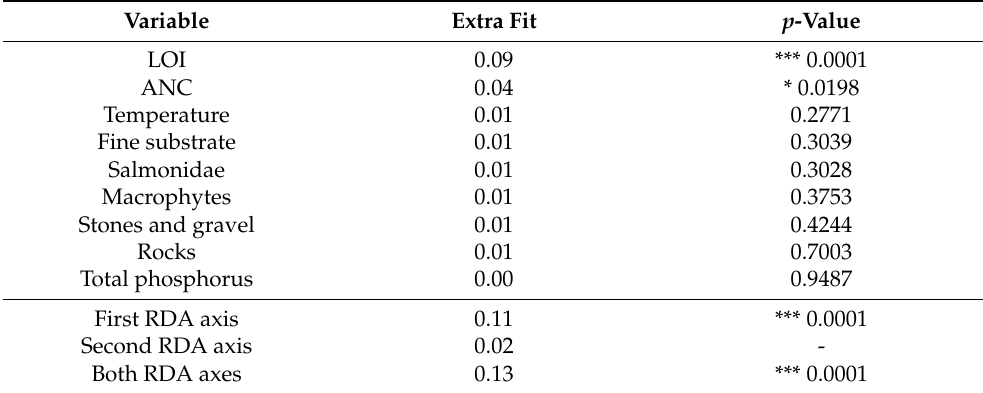
Table A2. Forward selection of environmental variables used in redundancy analysis (RDA) and resulting RDA axes. Significance ( p -values) refers to a Monte Carlo test with 9999 permutations, and it is performed on each environmental variable as a criterion to decide its inclusion in the model and on the final model (for the first RDA axis and both RDA axes combined). Asterisks denote significance: * p < 0.05, *** p < 0.001.